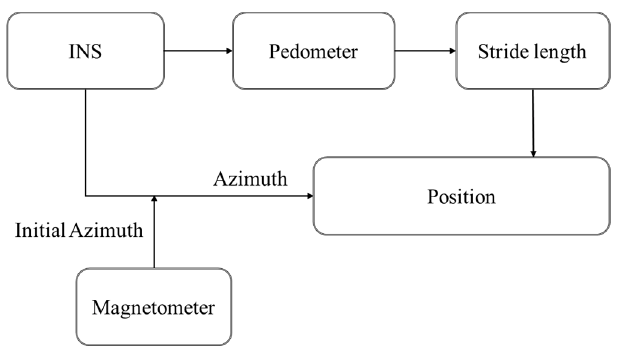
Figure 5. The pedestrian dead reckoning (PDR) scheme.